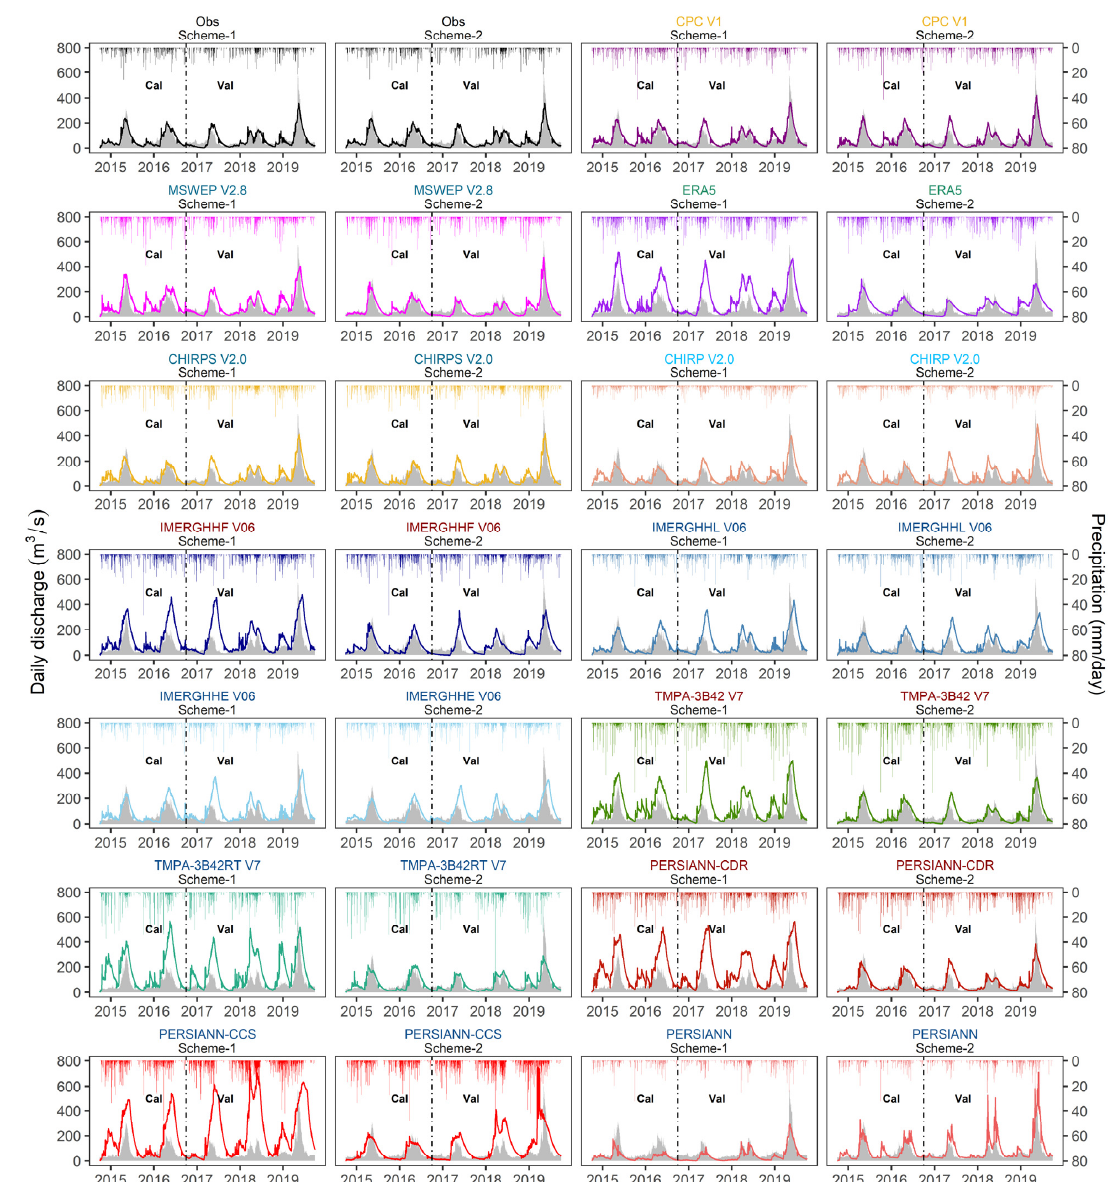
Figure 9. Comparison of the observed and simulated daily hydrographs at the Karasu basin outlet based on the observed data and 13 GPD input for the calibration (October 2014 to September 2016) and validation period (October 2016 to September 2019). Title color presents: observed (black), satellite-based (blue), gauge and satellite (red), reanalysis and satellite (sky blue), reanalysis (green), reanalysis, ground, and satellite (steel blue), and ground